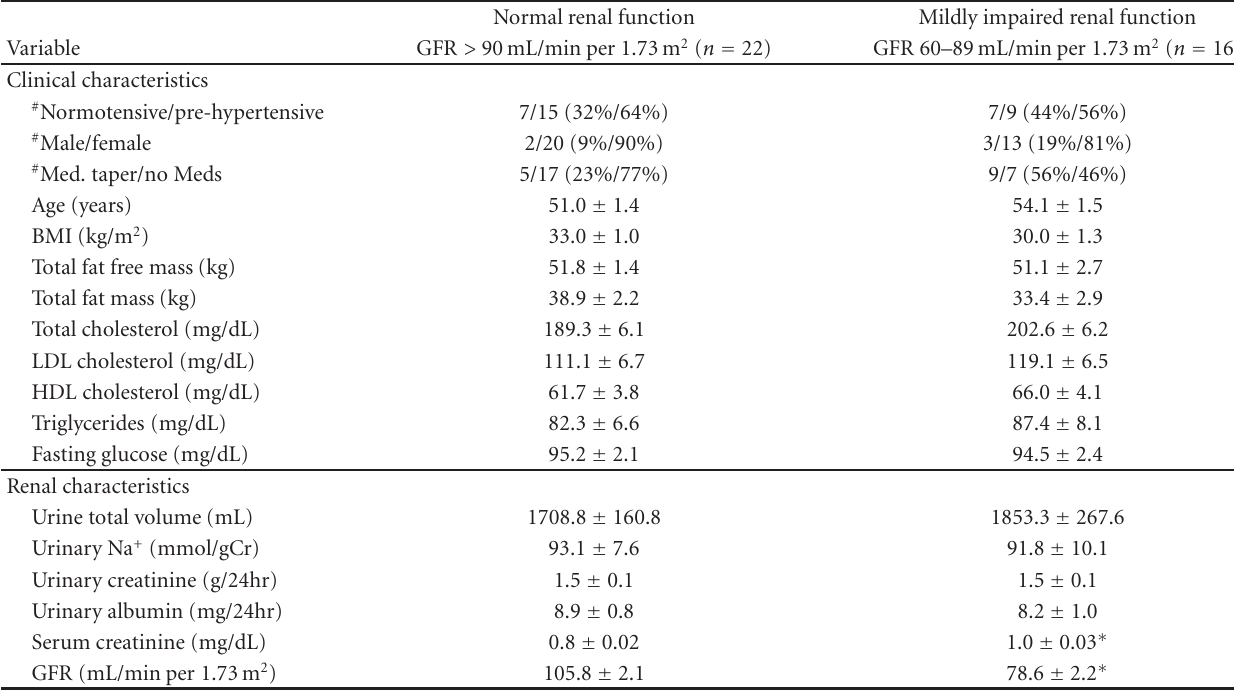
Table 1: Clinical and renal characteristics of normal or mildly impaired renal function groups.